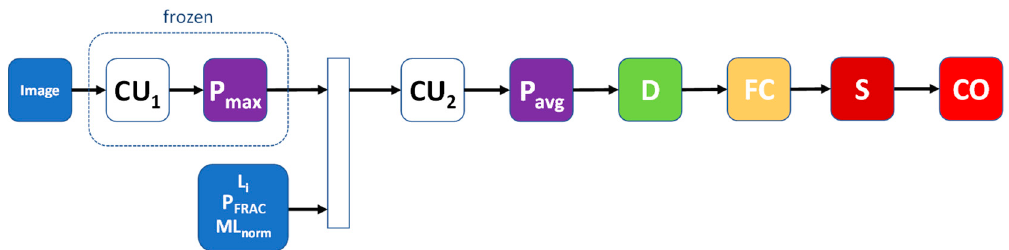
Figure 7. Architecture of the CNN disruption predictor.